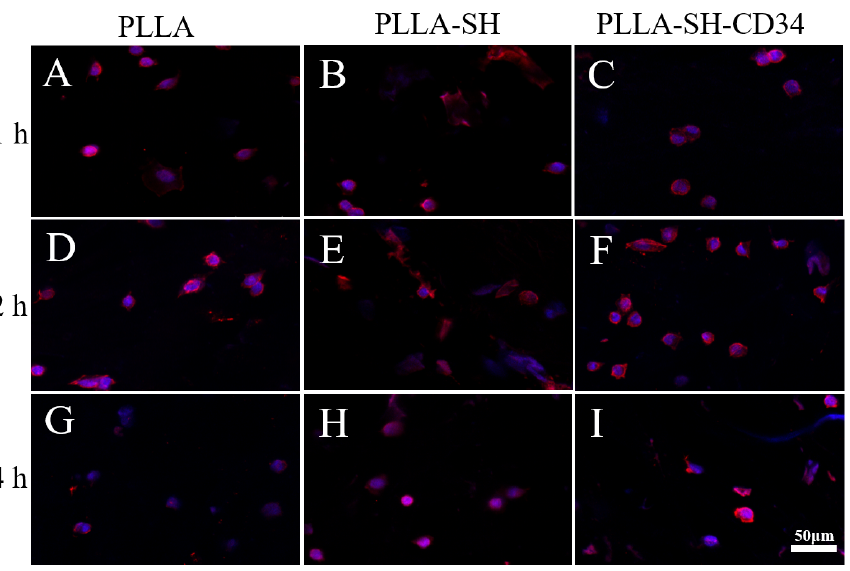
Figure 10. Growth of endothelial cells on different scaffolds at different times. The analysis was performed using phalloidin and nuclear staining.